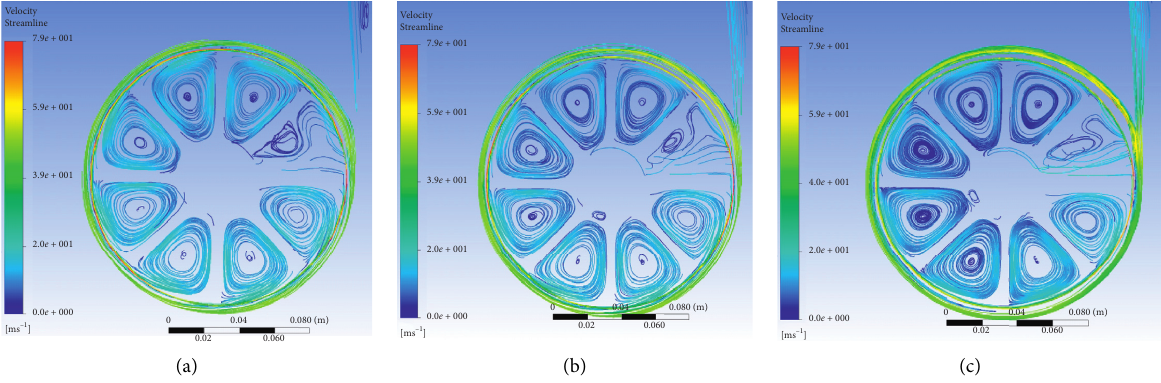
Figure 6: Streamline distribution with inducer at different flow rates. (a) Q